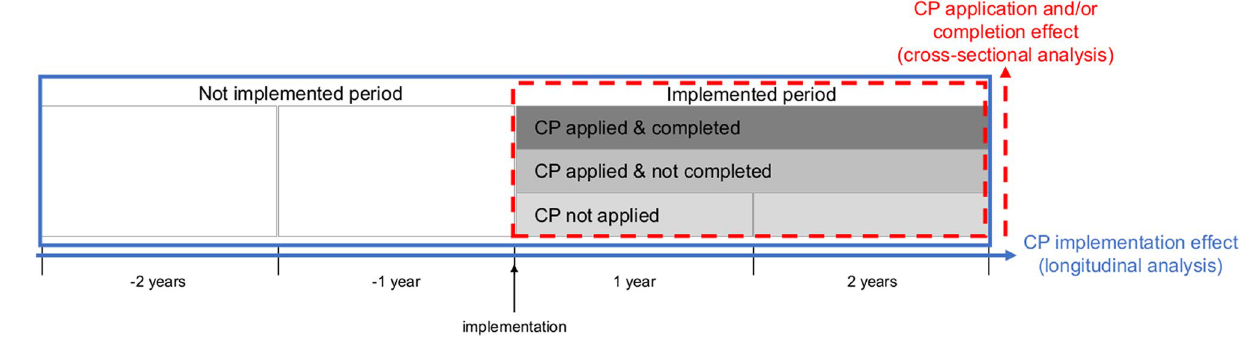
Figure 2. Observed adherence rate across the study period, with each line representing an individual clinical